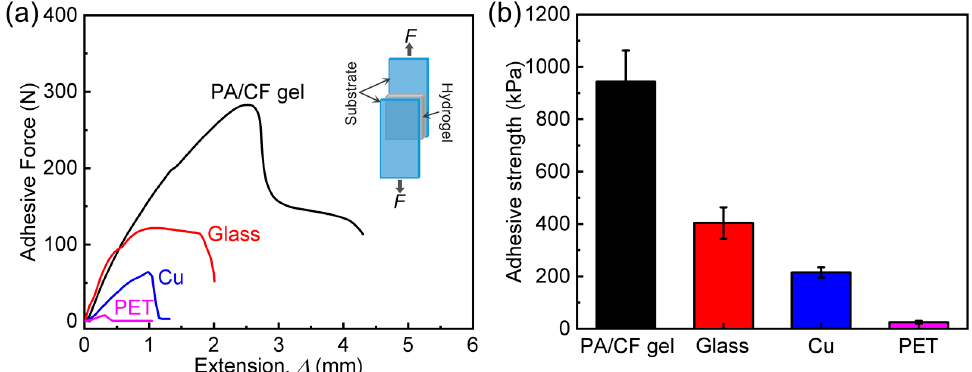
Figure 7. Adhesion behavior of PA/CF composite hydrogels with different φ CF to a glass substrate. ( a ) Adhesive shear force ( F )-extension ( ∆ ) curves of the samples. ( b ) Adhesive strength versus φ CF .